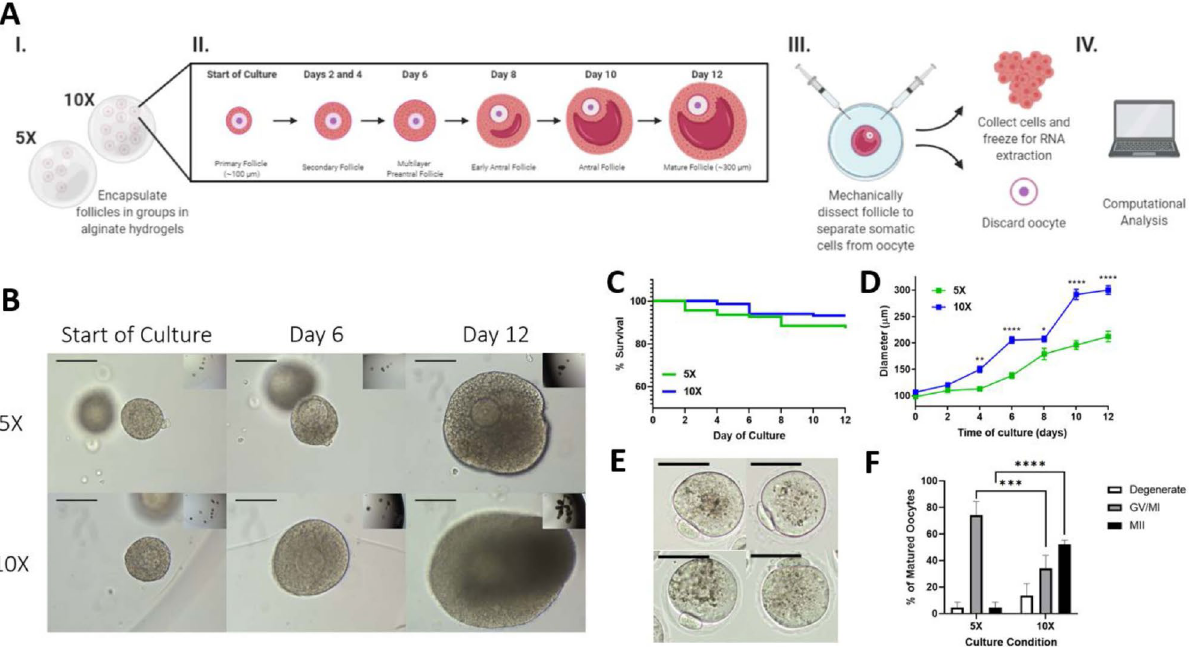
Figure 1. Ovarian follicles cultured in 10X have superior outcomes when compared to 5X culture. ( A ) Schematic describing the process of somatic cell isolation, beginning with primary follicles cultured in alginate hydrogels over 12 days, during which follicles are dissected at two-day intervals for cell collection, ( B ) bright field images of individual primary follicles encapsulated in alginate hydrogels in either groups of 5 or 10 (scale bar = 100 µm), ( C ) survival rates of follicles over duration of culture in 5X and 10X, ( D ) growth rates of follicles over duration of culture in 5X and 10X, and ( E ) metaphase II oocytes from follicles cultured in groups (scale bar = 50 µm), and ( F ) in vitro maturation rates for follicles cultured in 5X and 10X. N = 95 follicles for 5X and N = 140 for 10X in Fig. 2B–D. N = 39 follicles for 5X and N = 204 for 10X for Fig. 2F. * p < 0.05, ** p < 0.01, *** p < 0.001, **** p < 0.0001. ( A ) was generated using Biorender